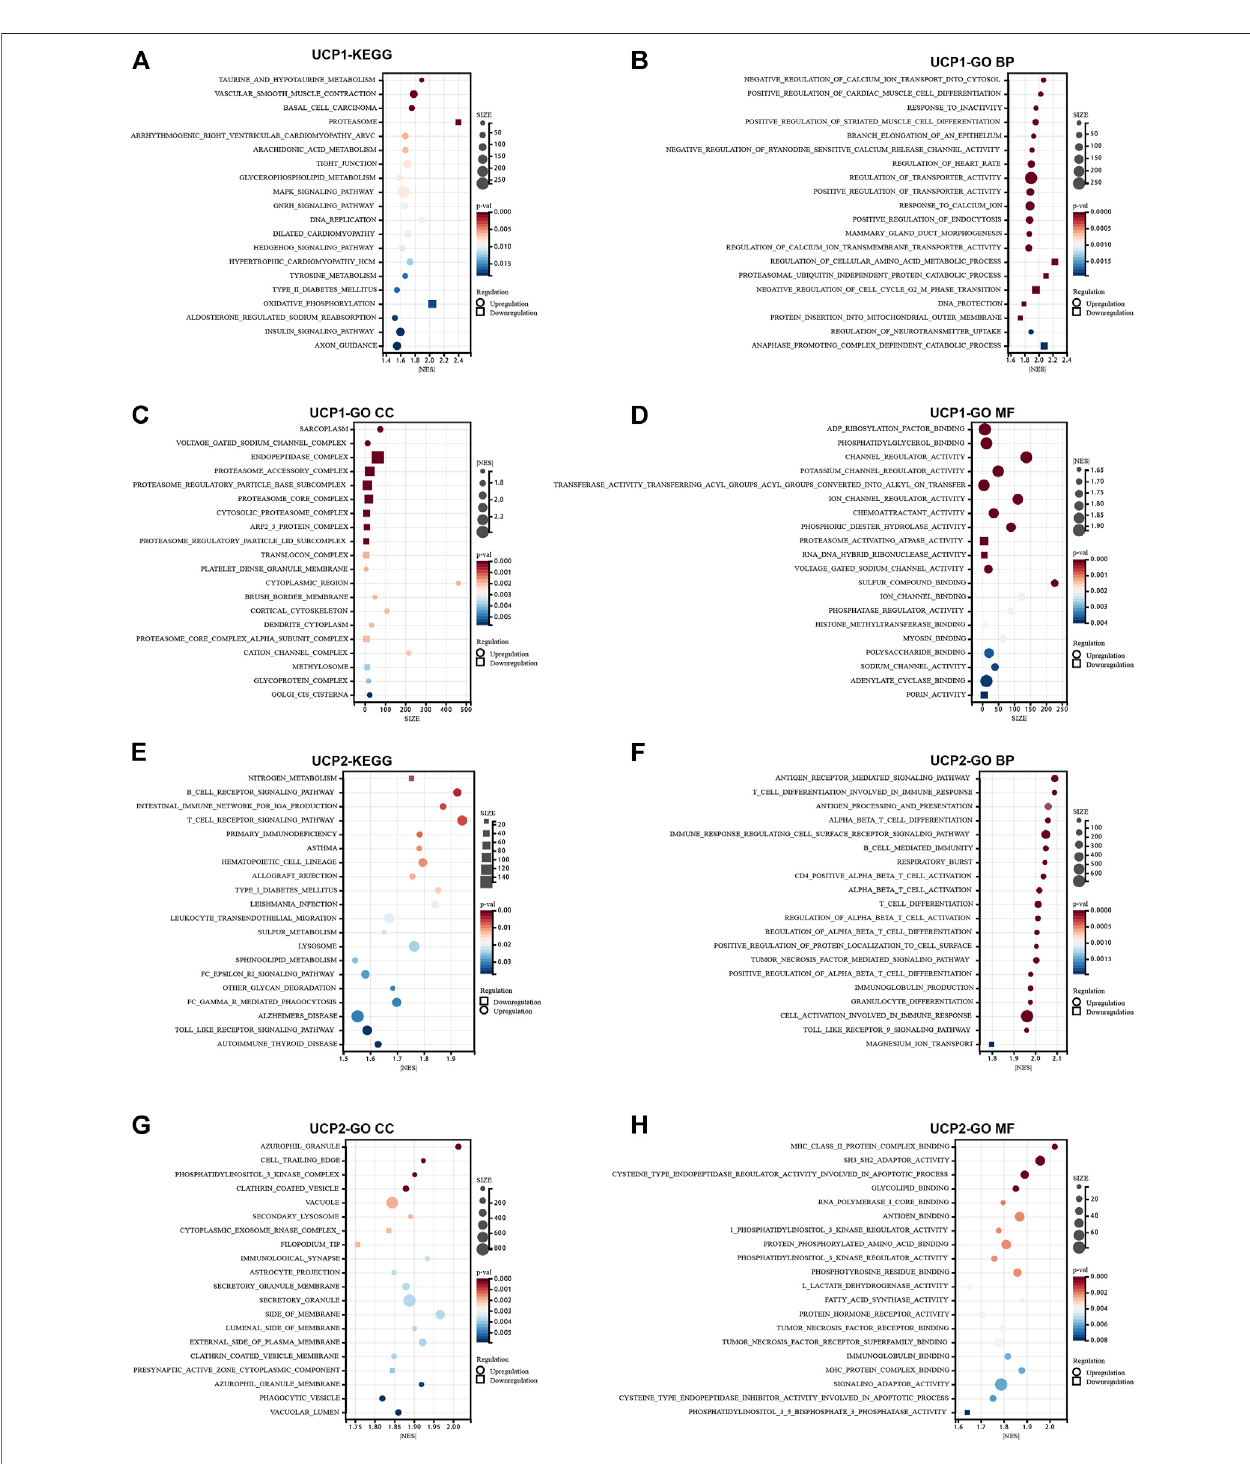
FIGURE 3 | FunctionalanalysisforUCP1andUCP2inbreastcancer. (A – D) FunctionalanalysisforUCP1byGSEAbasedongenesetsusing (A) KEGG, (B) GO-BP, (C) GO-CC, and (D) GO-MF. (E – H) FunctionalanalysisforUCP2byGSEAbasedongenesetsusing (E) KEGG, (F) GO-BP, (G) GO-CC,and (H) GO-MF.Onlypathwayswith p < 0.05arepresented.